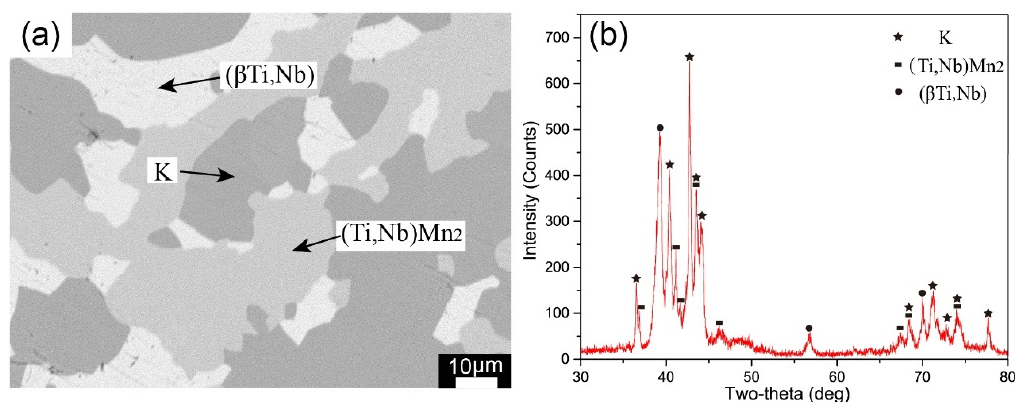
Figure 24. Alloy C5 annealed at 1373K for 40 days: ( a ) BSE images, ( b ) XRD patterns.